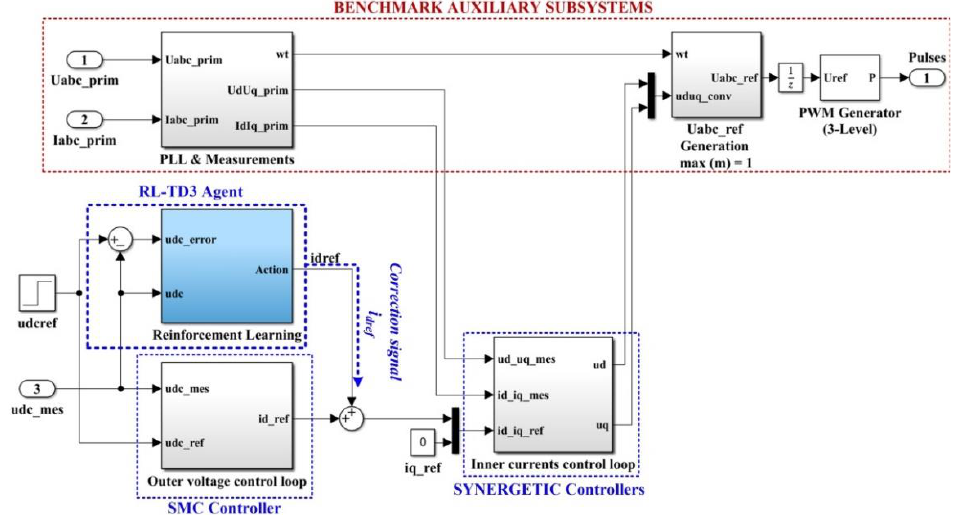
Figure 21. The block diagram of the MATLAB Simulink subsystem implementation of the control system for the GC-PV array based on SMC and SYN using the RL-TD3 agent for the correction of the i dref command.